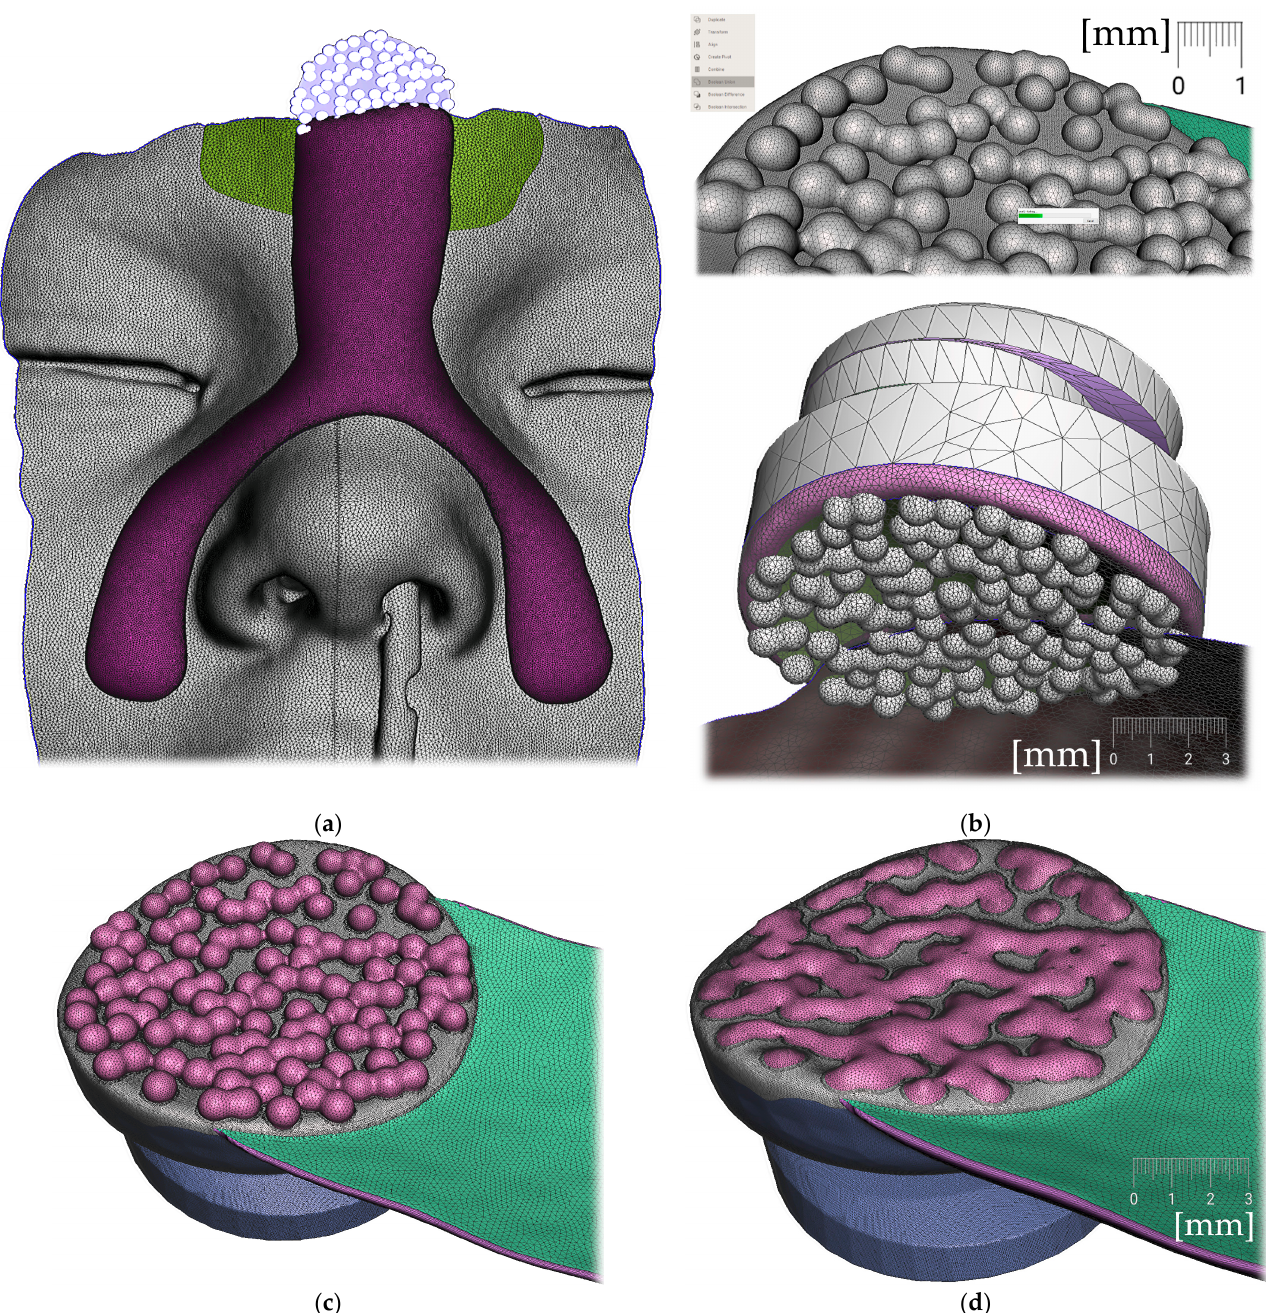
Figure 17. Extraoral part creation —Forehead button and anti-decubital surface creation: ( a ) definition of the pattern of spheres to achieve anti-decubital surface at the level of skin; ( b ) selected area -> Edit -> Make Pattern -> Tiled Spheres as pattern type, Clip to surface; ( c ) select both objects and perform Boolean Union followed by Smoothing; ( d ) final skin-facing smoothed anti-decubital surface of the button for extraoral elastic cap attachment.